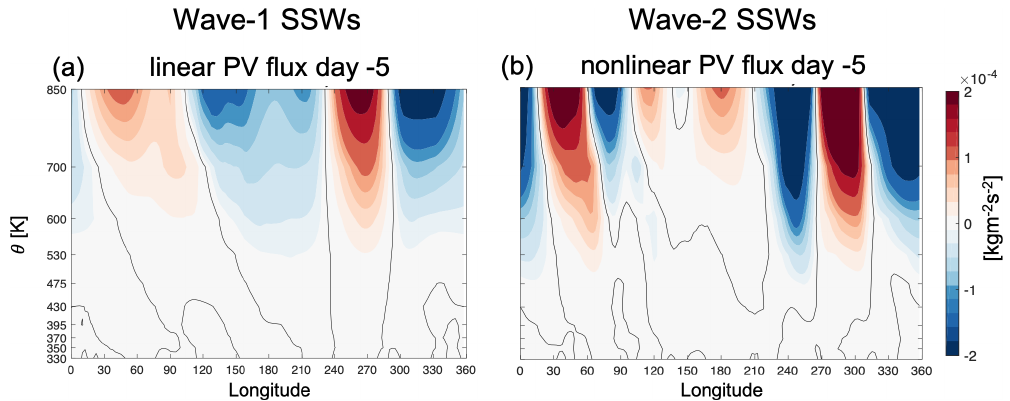
Figure 8. The longitude– θ cross section of PV flux averaged north of 45 ◦ N at day − 5. (a) Linear PV flux for wave-1 SSWs and (b) nonlinear PV flux for wave-2 SSWs. The black line indicates the zero value of PV